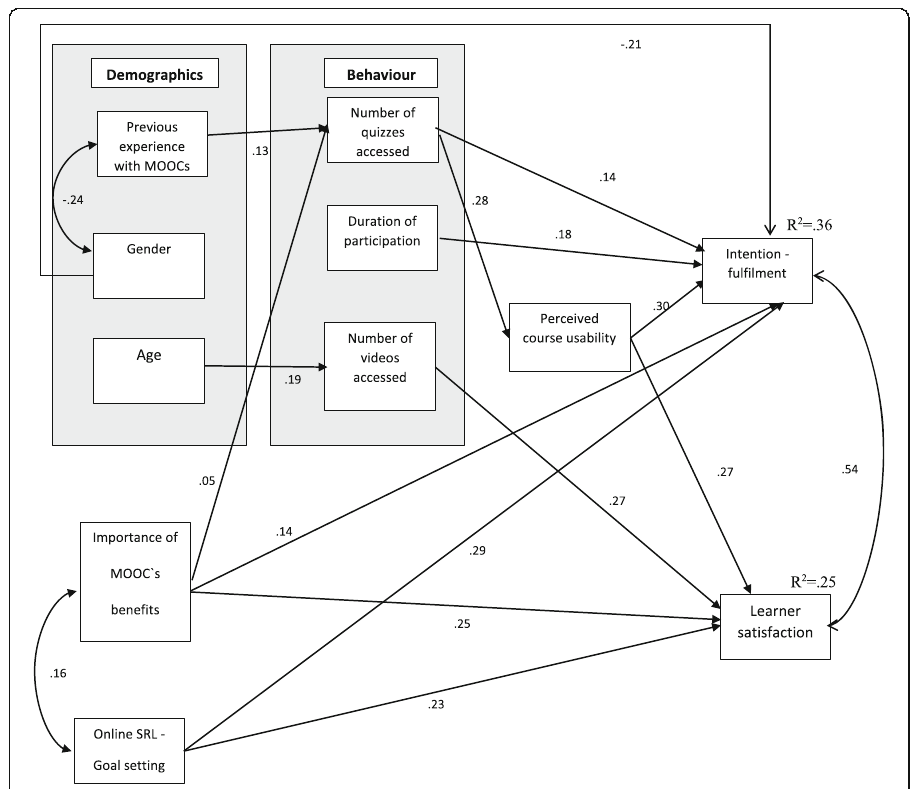
Fig. 2 SEM analysis presenting the significant factors influencing learner satisfaction and intention-fulfillment. Note: All the paths are significant at a p <.05 level. The estimations are presented using a standardized